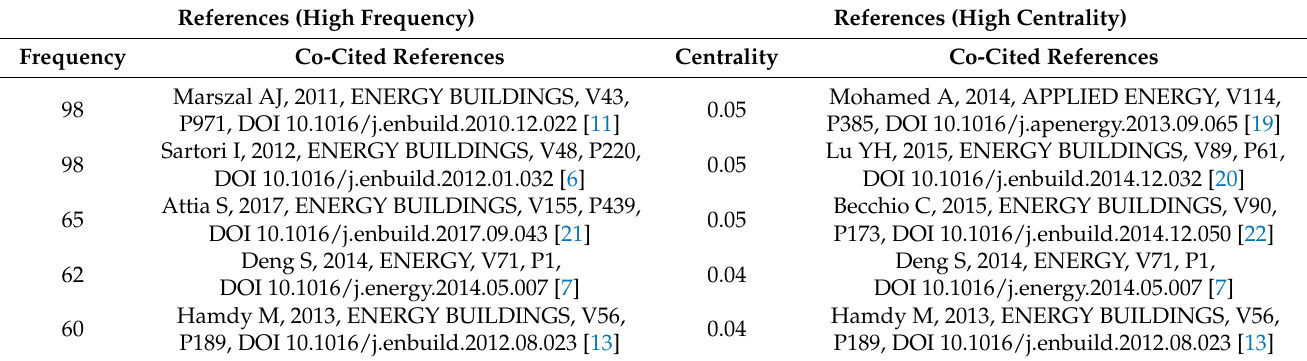
Table 10. Co-cited references with high frequency and high centrality.